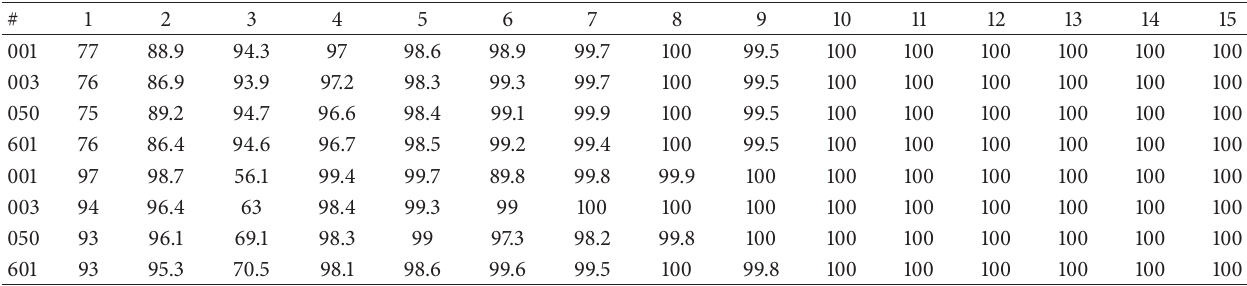
Table 11: Bit error rates on Gaussian blurring.